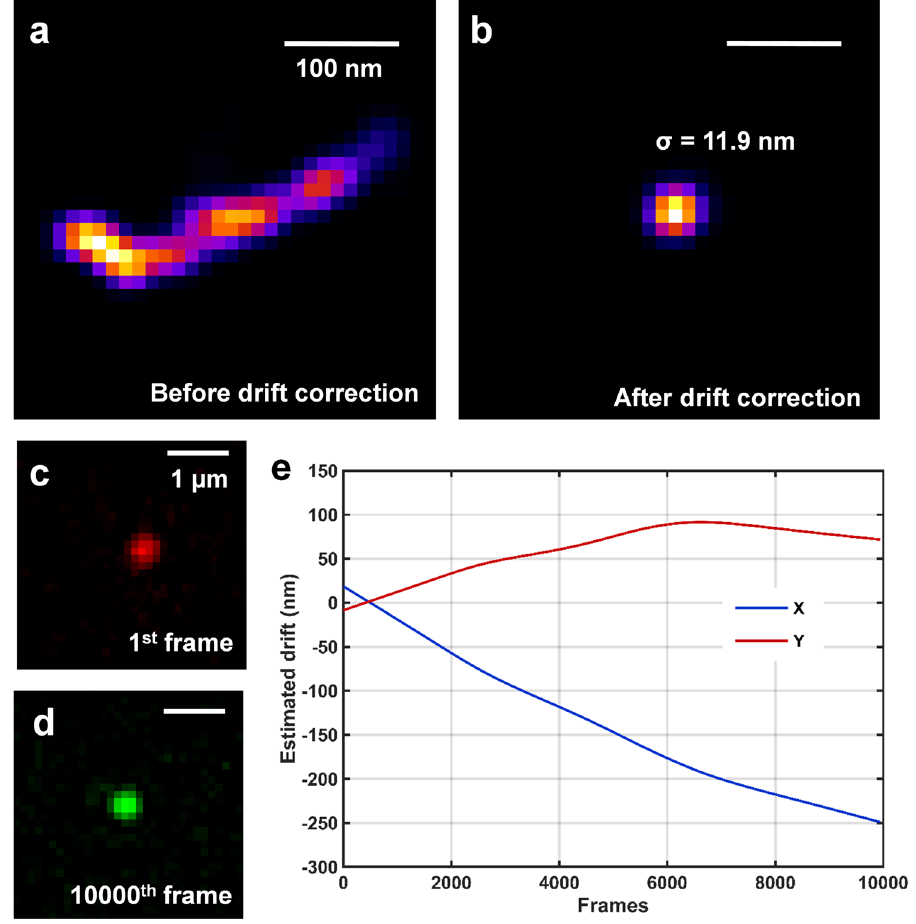
Figure 4. Performance of our low-cost SMLM for super-resolution imaging of nanoparticles. ( a , b ) Reconstructed super-resolution image of the nanoparticle ( a ) without drift correction and ( b ) with cross- correction based posteriori drift correction. Note that, the final localization precision of our low-cost SMLM setup is 11.9 nm. ( c ) The fluorescence image of the nanoparticle from the first image frame. ( d ) The fluorescence image of the same nanoparticle after ~7 minutes from 10000 th frame. The nanoparticle still stays at the focal plane without visible focus drift, suggesting that the effect of axial drift can be neglected for 2D imaging up to 10,000 frames. ( e ) The lateral sample drift for 10,000 frames estimated by the cross-correlation based drift correction algorithm integrated in